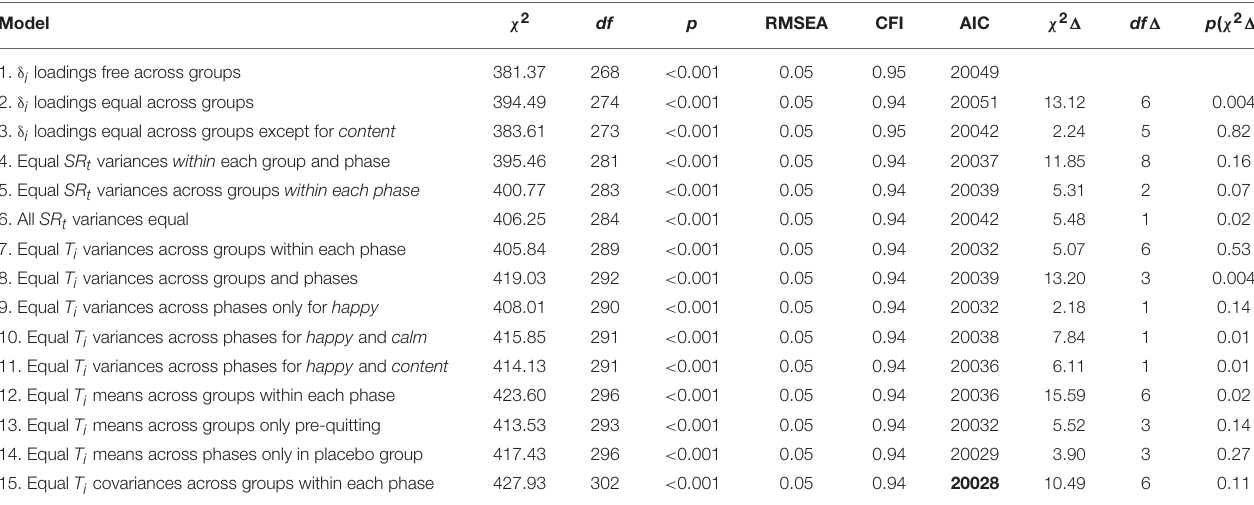
TABLE 2 | Model goodness-of-fit measures for different MG-MP-LST models with indicator-specific trait factors fit to smoker’s affect data.